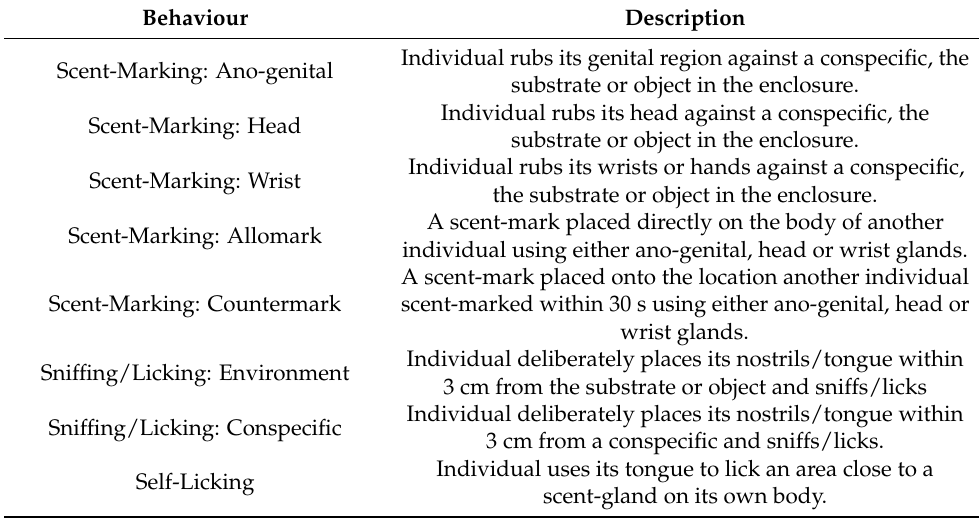
Table 1. Ethogram (based on [9,21], modified).